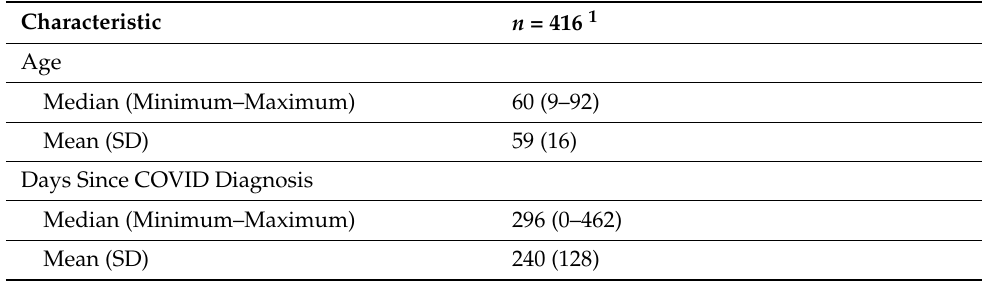
Table 1. Baseline demographics and